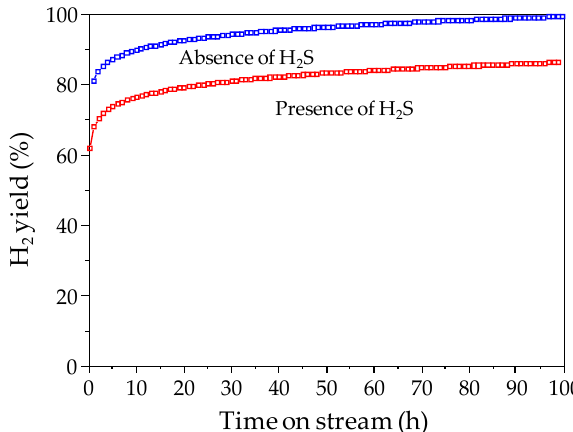
Figure 16. Long term catalyst testing in ATR of CH 4 (T = 850 °C, CH 4 :H 2 O:O 2 = 1:2.5:0.75) of ATR catalyst developed in DEMCAMER project.